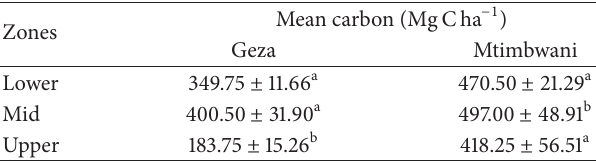
Table 4: Horizontal profile of soil carbon stocks (mean ±